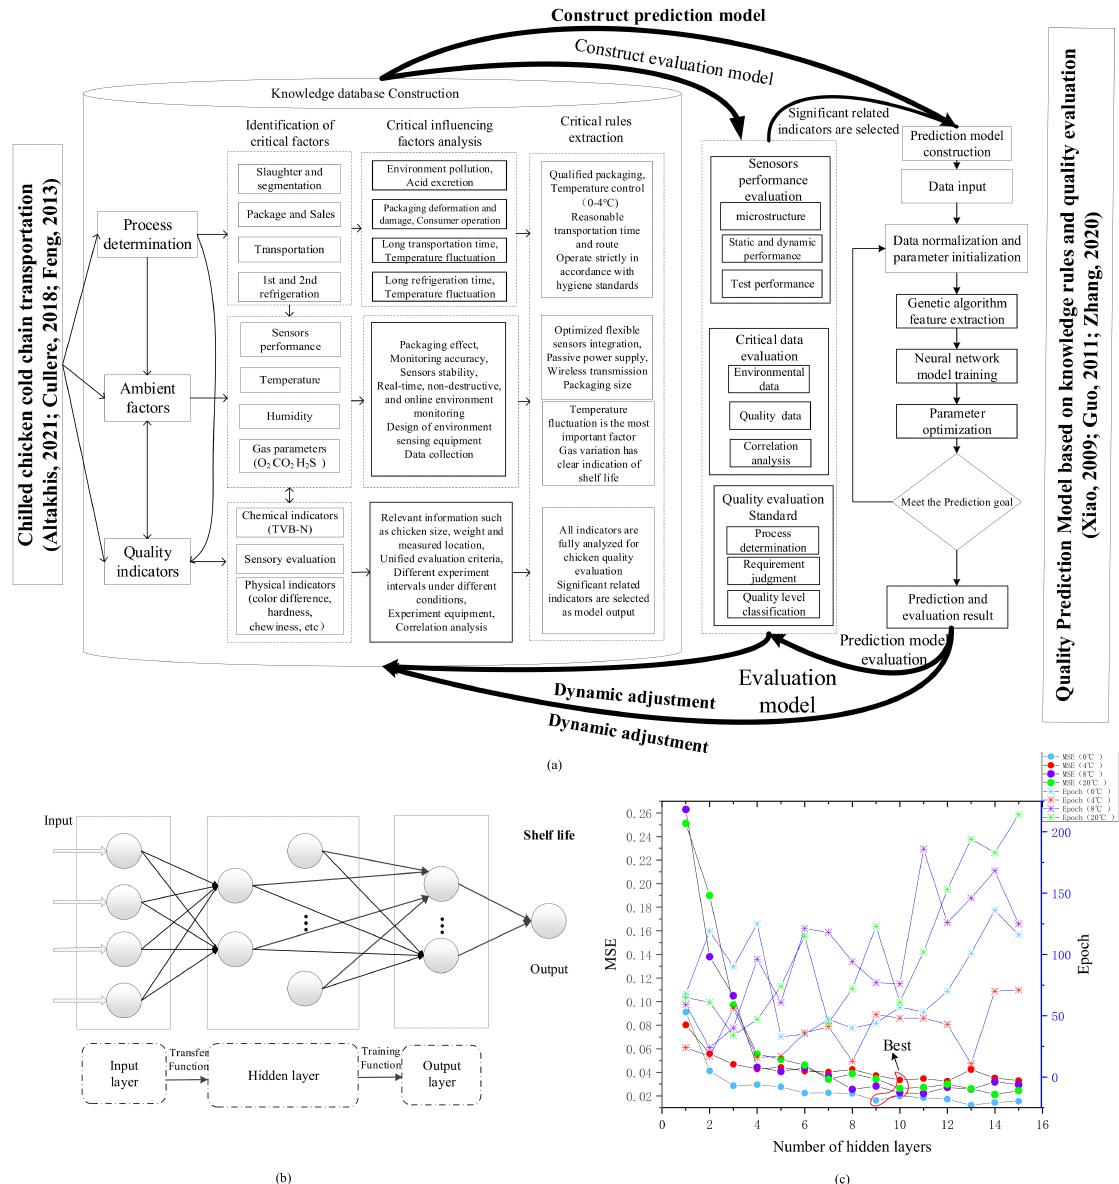
Figure 1. Intelligent dynamic quality prediction model based on knowledge rules and evaluation standard. ( a ) Model construction; ( b ) Prediction model design; ( c ) Prediction model parameter